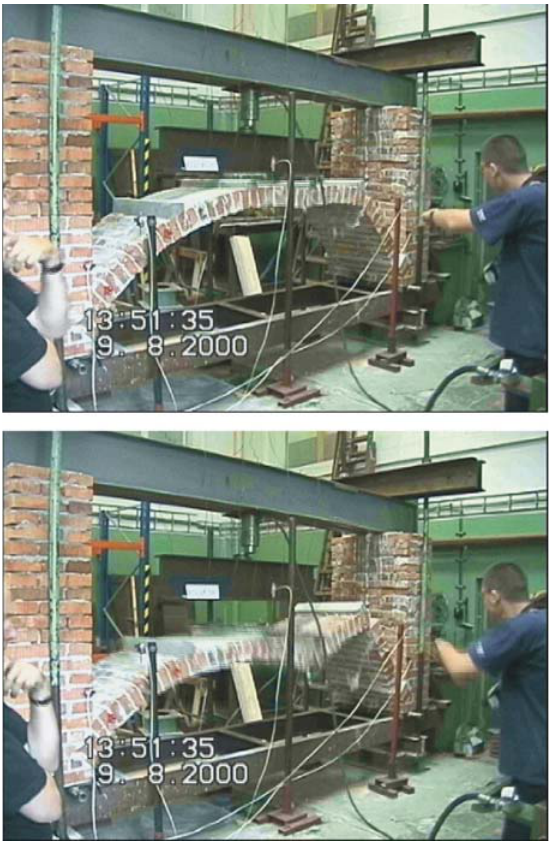
Fig 3. Vault failure under load (buckling of right vault section)